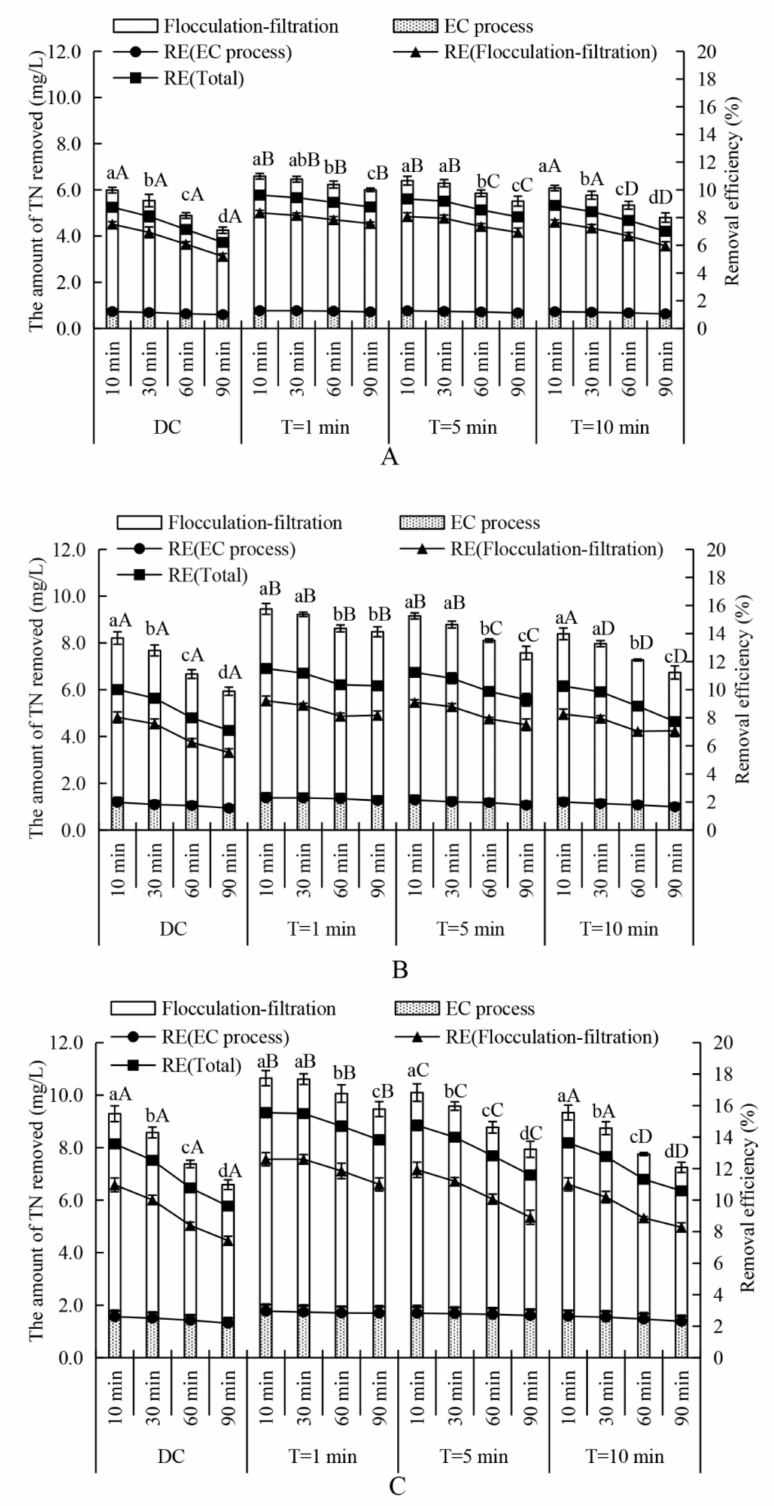
Figure 6. Effects of current density and CCP on the removal of TN by the EC − filtration system: ( A ) j = 15 A/m 2 , ( B ) j = 30 A/m 2 , ( C ) j = 45 A/m 2 . In the same CCP, different lowercase letters on the RE(Total) indicate significant differences ( p < 0.05). At the same current density across different CCPs, different uppercase letters on the RE(Total) indicate significant differences ( p <